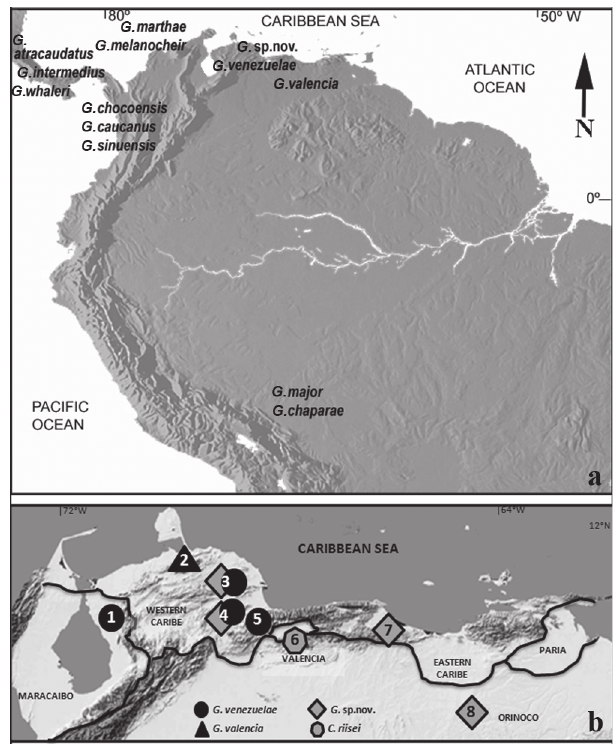
Fig. 1. a. Geographical distribution of species of Gephyrocharax . b. Sampling sites for Gephyrocharax and Corynopoma riisei in Venezuela. 1. La Pedregosa River, Machango River basin, Zulia State. 2. Meachiche River, Falcón State. 3. Aroa River, km 26, Palma Sola, Falcón State. 4. Las Peñas de Taría River, Yaracuy River basin, Yaracuy State. 5. Alpargatón River, Urama River basin, Carabobo State. 6. La Cumaca River, San Diego River basin, Carabobo State. 7. La Maleja creek, Guapo River basin, Miranda State. 8. Pao River, Orinoco River basin, Anzoátegui State. In sites 3 and 4 G. venezuelae and G. valencia occur sympatrically. Limits between major river basins (Lake Maracaibo, Caribe, Paria, and Orinoco) follow Mago-Leccia (1970) and are indicated with a solid